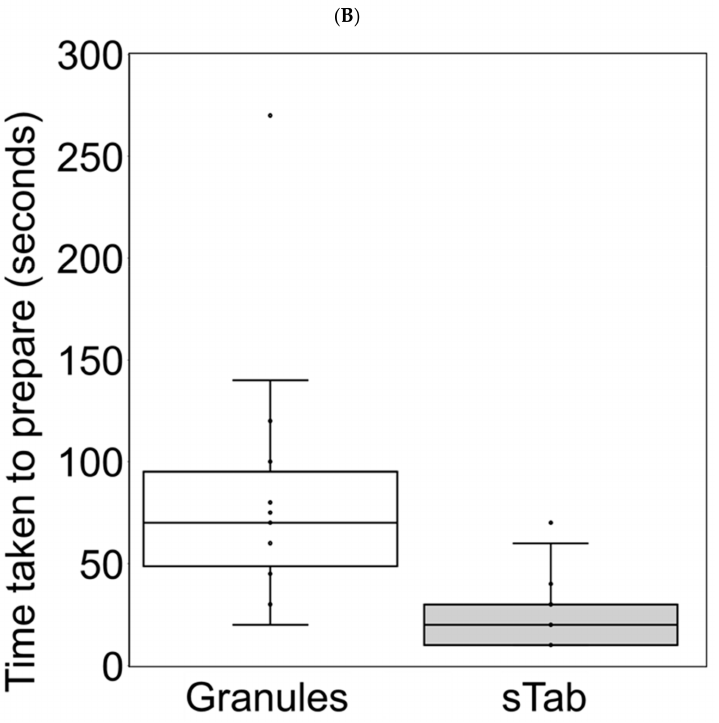
Figure 2. Time taken to prepare the Sulfamethoxazole trimethoprim combinations. Each plot showed the preparation time for each case. The center line indicated the median, boxes indicated first and third quartile range (IQR), whiskers indicated upper or lower fence, and plots outside the fence indicated outliers (1.5 × IQR). White boxes indicate preparation times for conventional tablets ( A ) or granules ( B ); black boxes indicated preparation times for small tablets ( A , B ). cTab, conventional tablet; sTab, small tablet.